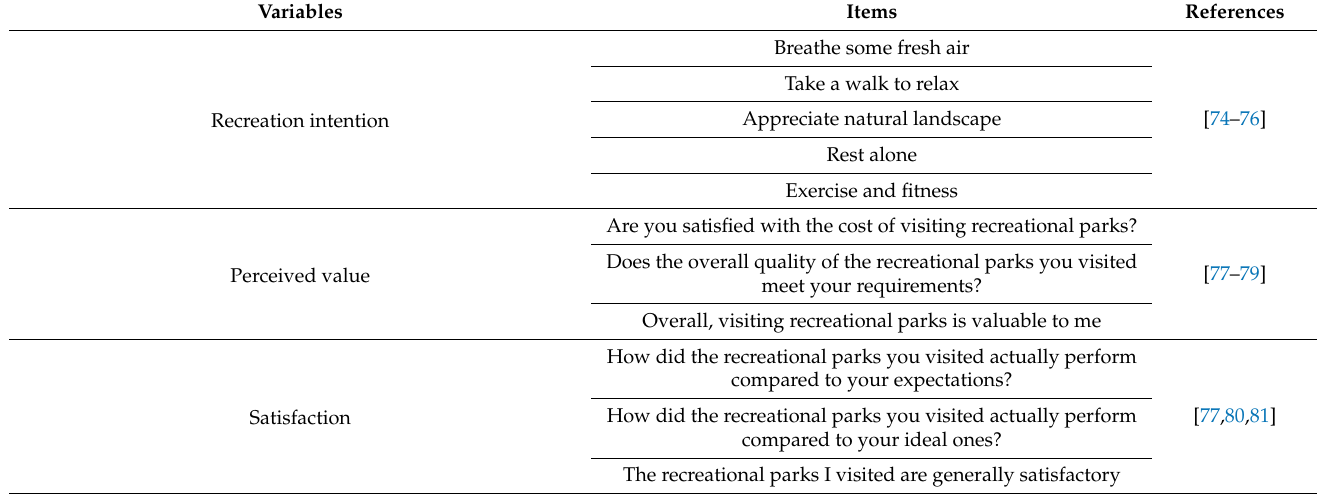
Table A2. Scale of park recreation satisfaction model for blue-collar workers.